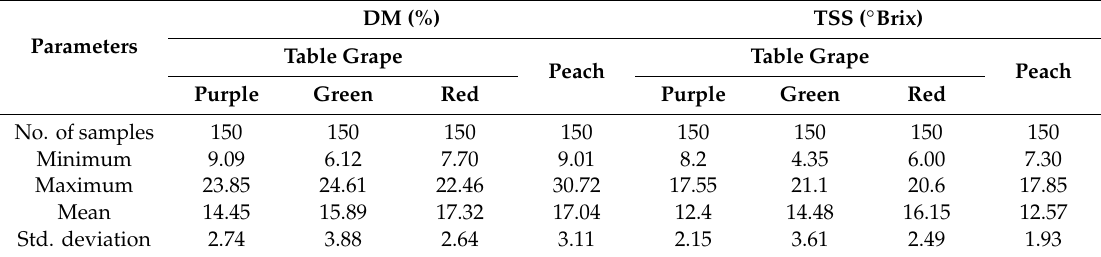
Table 1. Descriptive statistics for table grape and peach sample quality attributes.